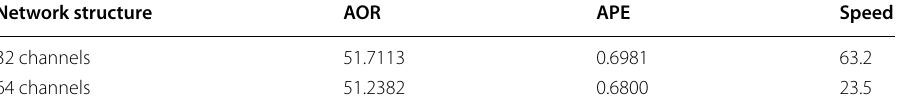
Table 1 Success and precision plots on OTB2013 datasets with different network structure Network